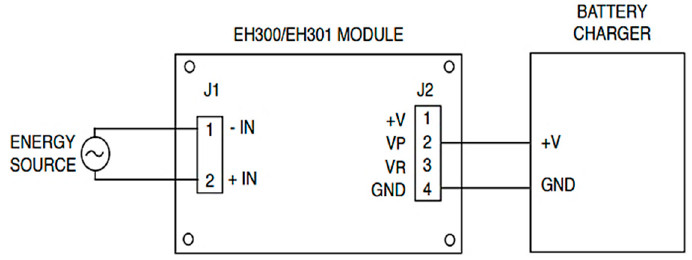
Figure 1. EH301A Charging Configuration [43].